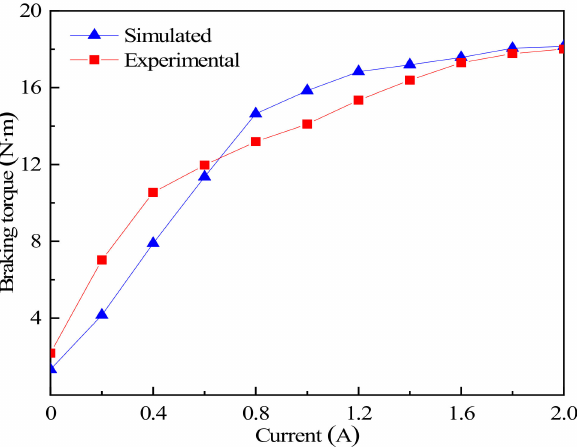
Figure 14. Variation of simulated and experimental braking torque.